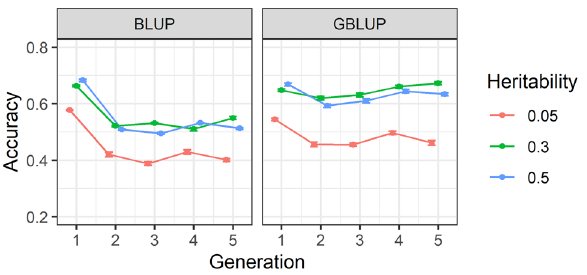
Figure 4. Accuracy of (genomic) estimated breeding values (G)EBV within five generations. The accuracies are provided for heritability of 0.05, 0.3 and 0.5. Accuracies in BLUP were averaged over two family types and ten replicates, while for GBLUP are estimated by averaging correlations over two family types, ten replicates, four marker densities and four genotypic error rates. Standard errors of accuracies are shown as error bars.